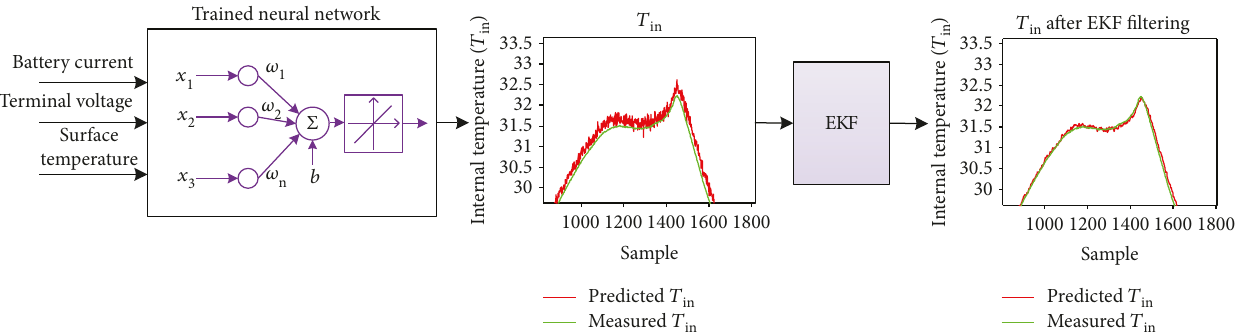
Figure 5: The developed approach combines the NN and EKF to estimate T